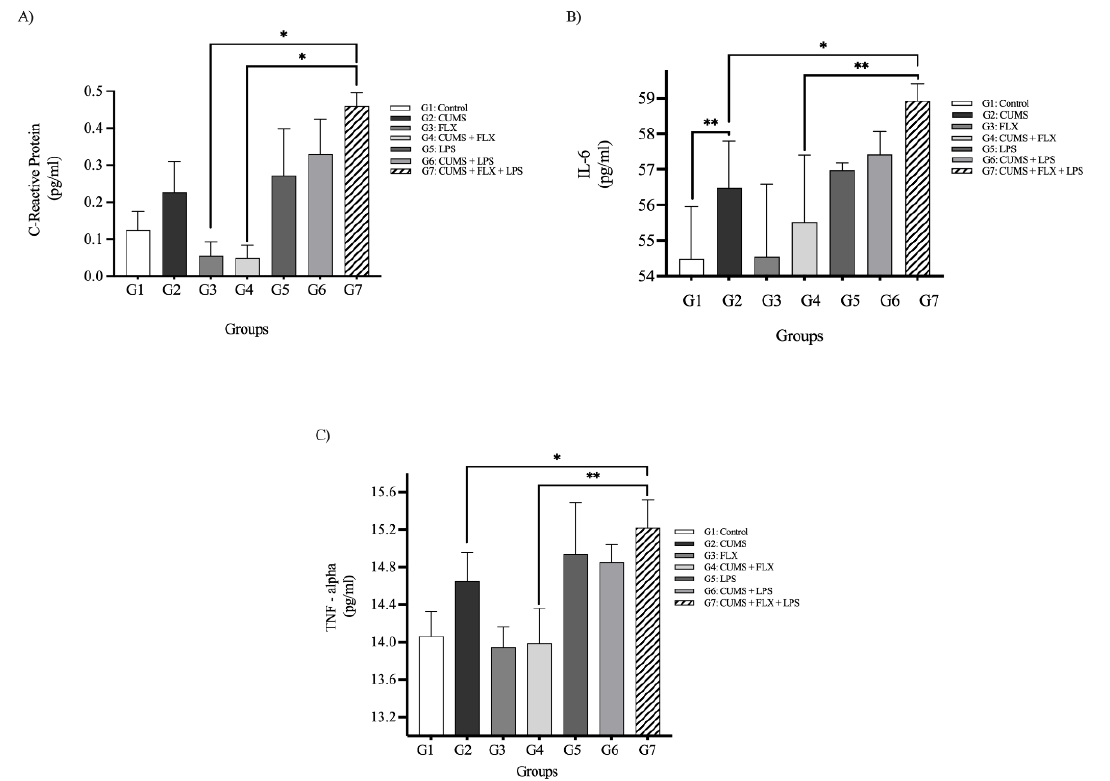
Figure 8. ( A – C ) Effects of Lipopolysaccharide on Cytokines Markers (IL-6, TNF- α , and C-Reactive Protein (CPR) Serum Levels in Fluoxetine-Resistant Depression Rats Exposed to CUMS model: Data are expressed as the means ± SEM; n = 5. Group comparisons were performed using one-way ANOVA followed by a Turkey-Kramer post hoc test; * p < 0.05; ** p < 0.01;. CUMS: chronic unpredictable mild stress: FLX: fluoxetine; LPS: lipopolysaccharide; IL-6: interlukien-6; TNF-alpha: tumor necrosis factor -alpha.